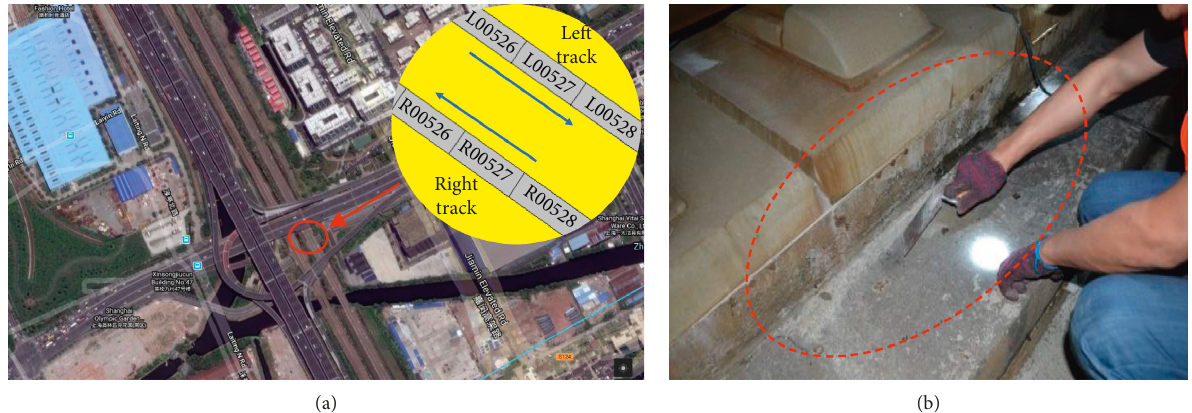
Figure 8: Monitoring site: (a) Site location; (b) Repair work of the L00526 track plate.